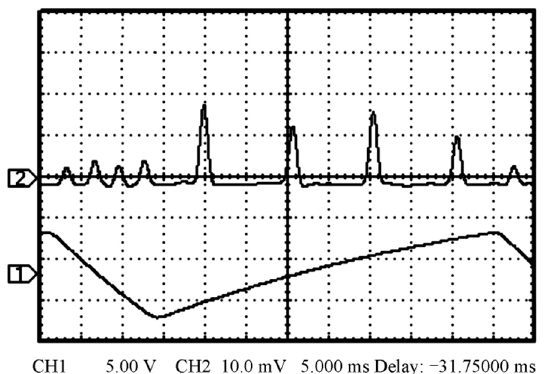
Figure 9. Oscillating spectrum of dual-frequency laser [24] .